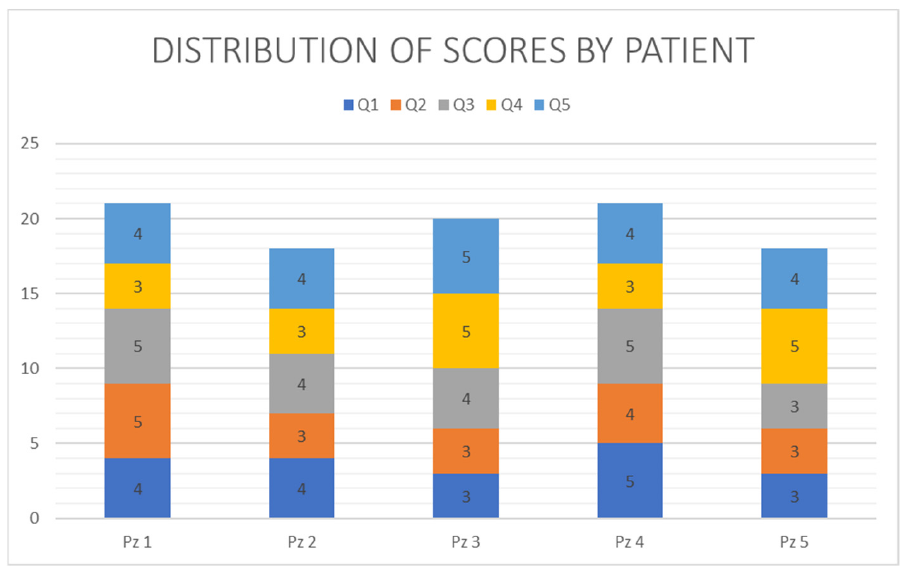
Figure 5. Distribution of score. Table 1. Patients’ questionnaire